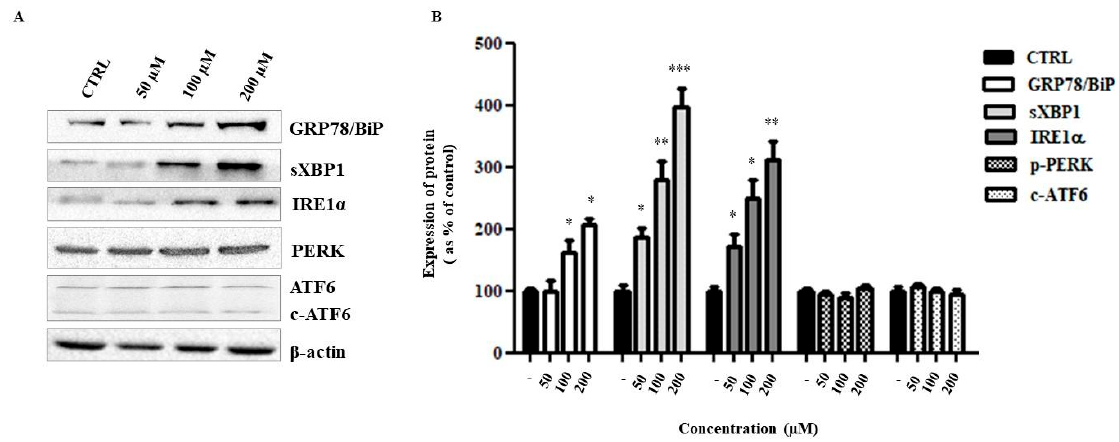
Figure 7. Activation of IRE1-XBP1 branch of UPR in HepG2 cells treated with liposomal ANP0903 for 24 h at indicated concentrations . ( A ) Representative Western blot and ( B ) densitometric analysis of immunoreactive bands. Protein levels were presented as the fold change relative to control cells (CTRL). PERK and ATF6 branches were not activated, as highlighted by unaltered expressions of the proper markers. β -actin was used as the loading control. Data are expressed as means ± Standard Error (SE) of three independent experiments, and statistical significance was evaluated by Kruskal– Wallis test (* p <0.05, ** p <0.01, *** p <0.001 vs. CTRL).